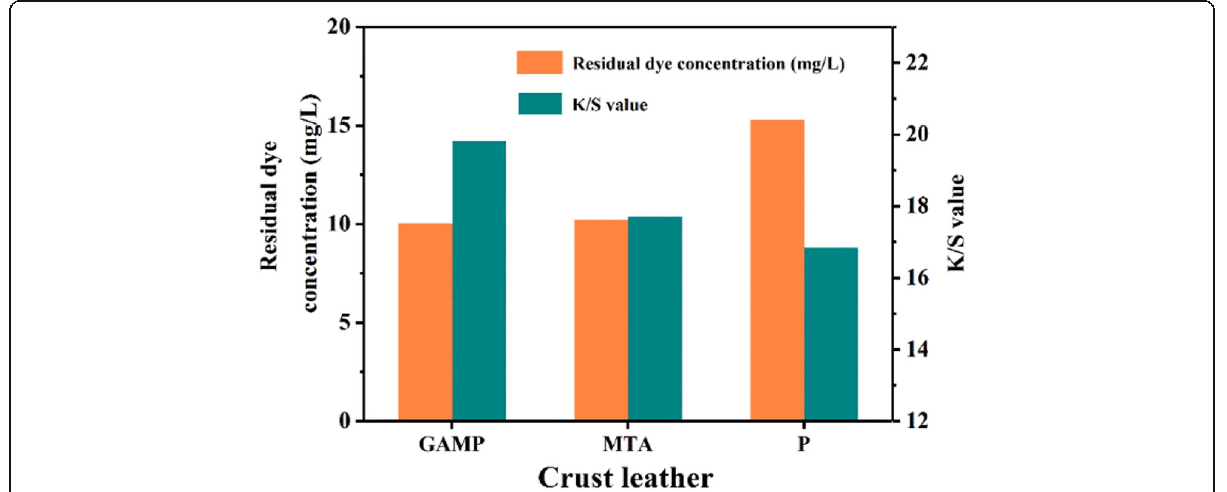
Fig. 7 K/S value of leather samples retanned with the different retanning agents and residual dye concentration in dyeing wastewater of the retanned leathers